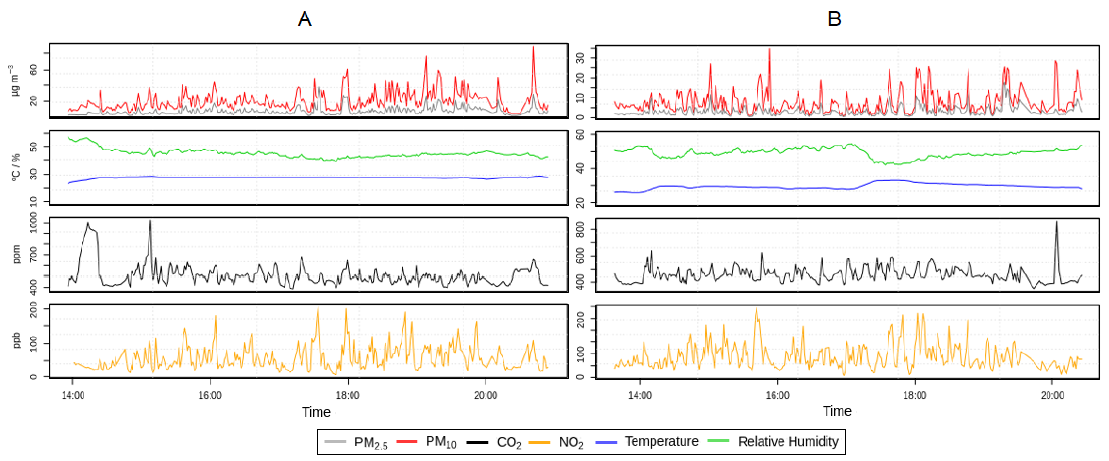
Figure 4. Time series plot of the exposure of a professional driver in a waste removal truck during a working shift. The Air Filtration System (AFS) was switched off on August 12 ( A ), and it was turned on on August 14 ( B ). Note the different scales of the